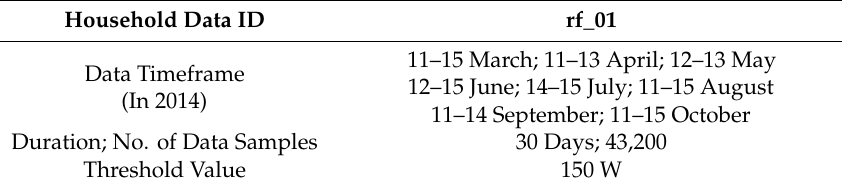
Table 2. Load data and event detection attributes.